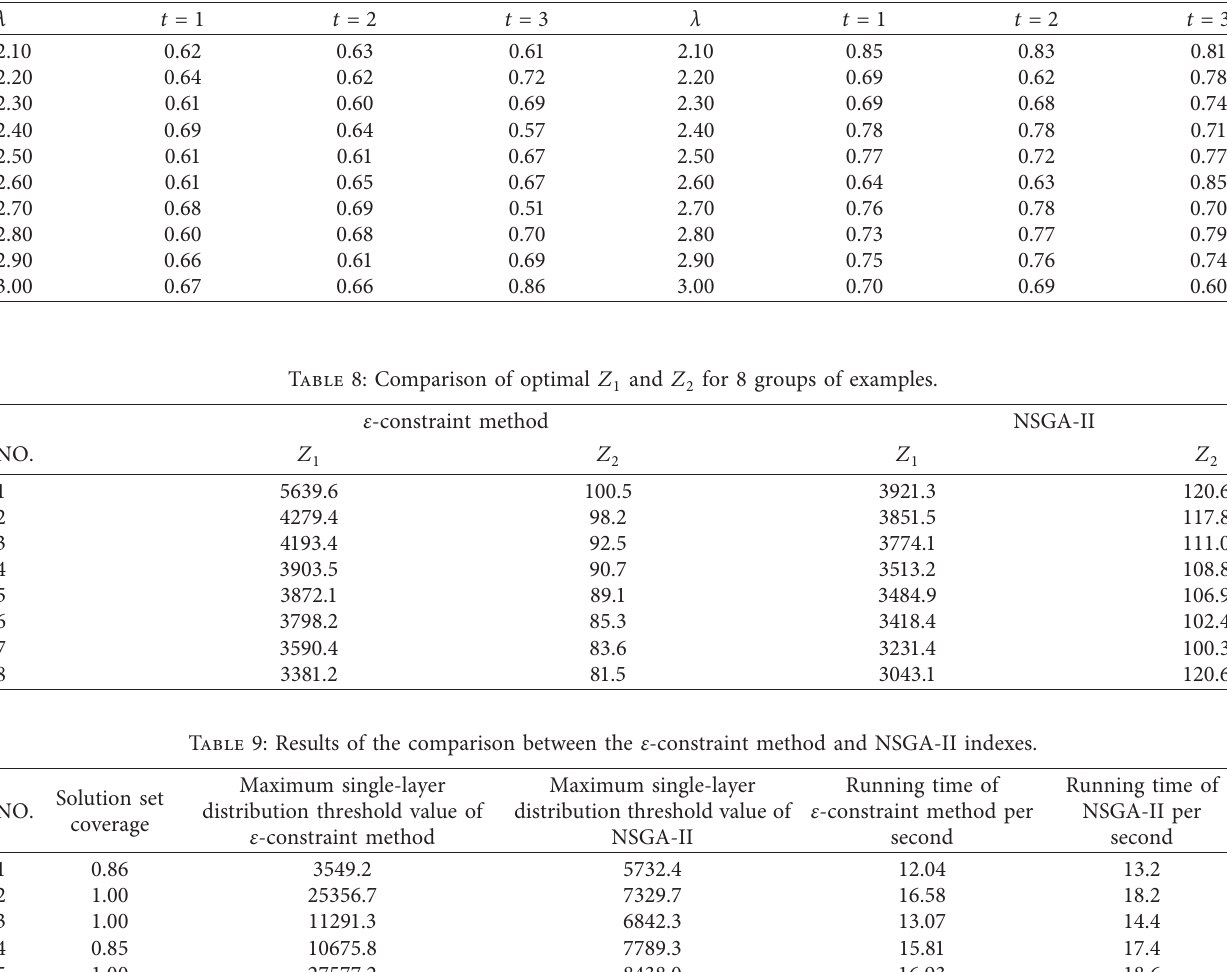
Table 7: The impact of λ change on downstream firms’ subjective utility.